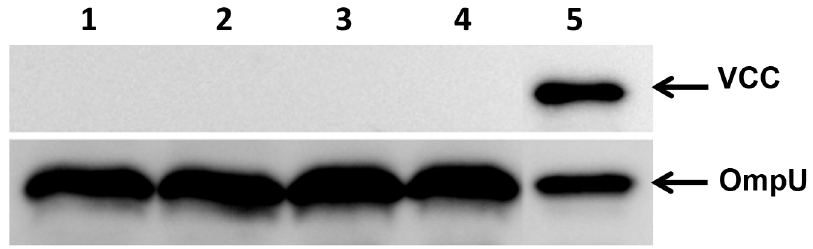
Figure 5. Re-association tests with VCC and OMVs. Immunoblot analysis using anti-VCC antiserum (upper panel) and anti-OmpU antiserum (lower panel). OmpU was used as an internal control to show the presence of OMVs in the samples. Samples with equal amounts of OMVs from the D vcc mutant were incubated with PBS (lane 1), with 0.6 nM of purified VCC (lane 2), with vesicle free supernatant from the wild type strain V:5/04 (lane 3), with vesicle free supernatant from the V:5/04 D vcc strain (lane 4). V:5/04 OMVs was used as a positive control sample (lane 5).